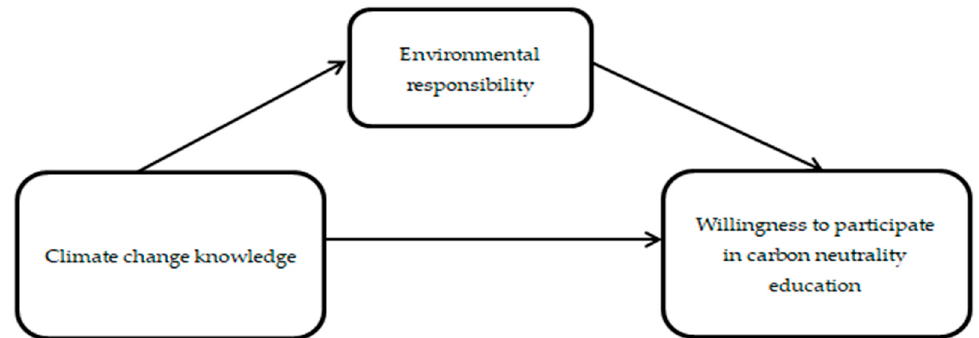
Figure 1. Theoretical Model.